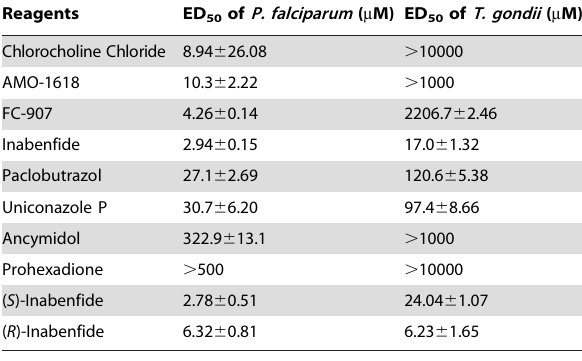
Table 1. ED 50 of the gibberellin biosynthetic inhibitors.